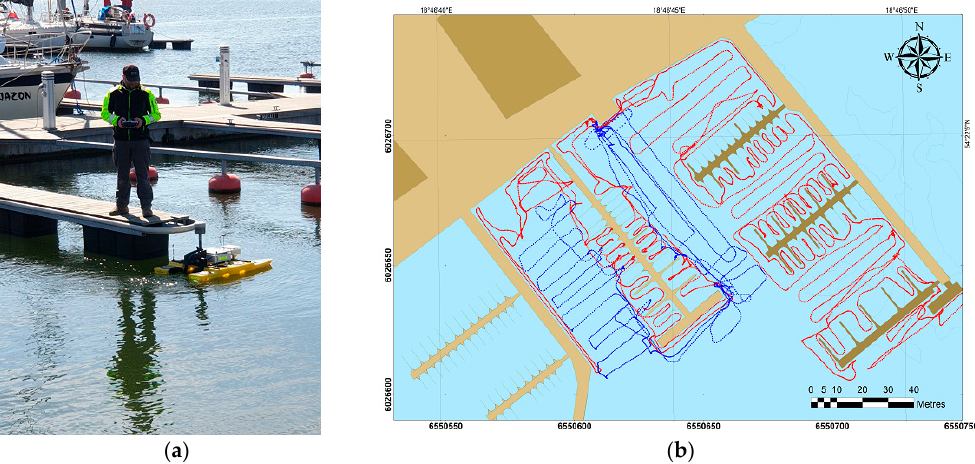
Figure 6. Unmanned Surface Vehicle (USV) surveys in the yacht port during the direct control ( a ), and the trajectory of bathymetric measurements in the harbor ( b ).